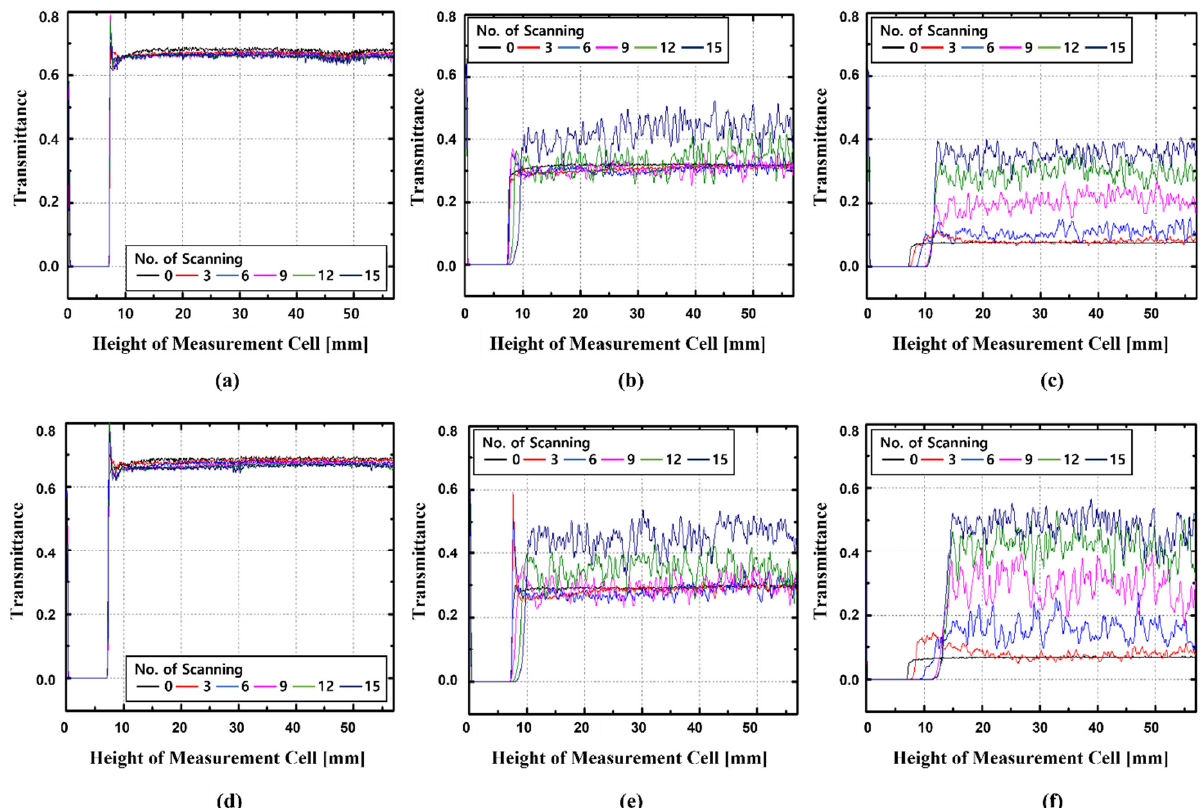
Figure 5. Dispersion stability: ( a ) BFO1, ( b ) BFO2, ( c ) BFO3 without ultrasound; ( d ) BFO1, ( e ) BFO2, ( f ) BFO3 with ultrasonic irradiation after 120 min.